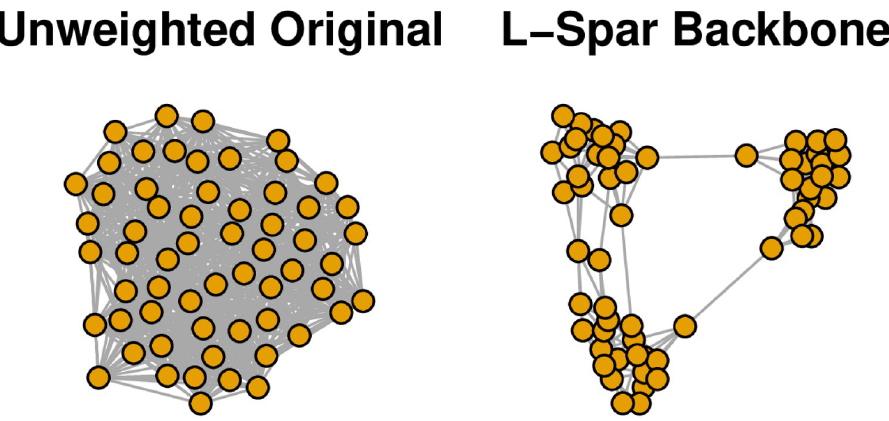
Fig 6. Extracting the backbone of an unweighted network with embedded communities (toy